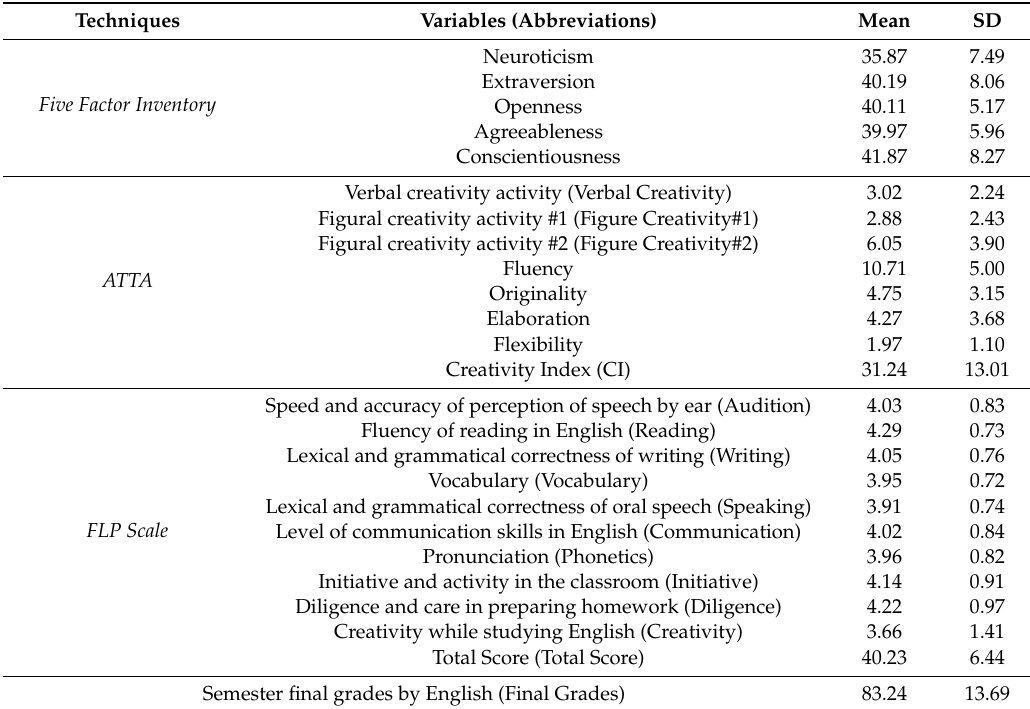
Table 2. Significant best predictor regression models for FLP assessments.